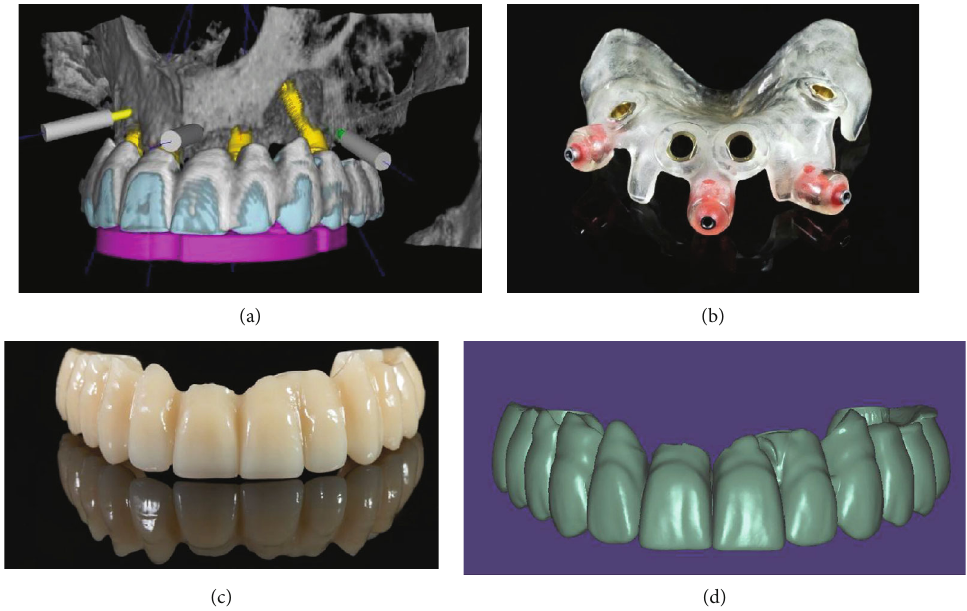
Figure 5: (a) Planning the surgical template. (b) Finished printed surgical template. (c) Design of the provisional FPD. (d) Finished provisional FPD milled from